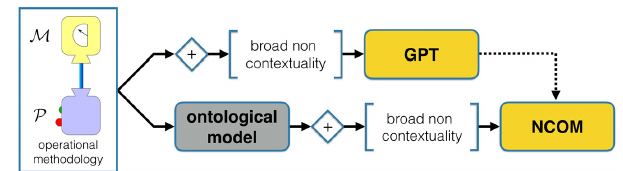
FIG. 1. The diagrammatic representation of different model constructions for operational descriptions of experiments. The dotted arrow represents the detour approach for building NCOMs for GPTs. A GPT that admits a NCOM is called ontologically